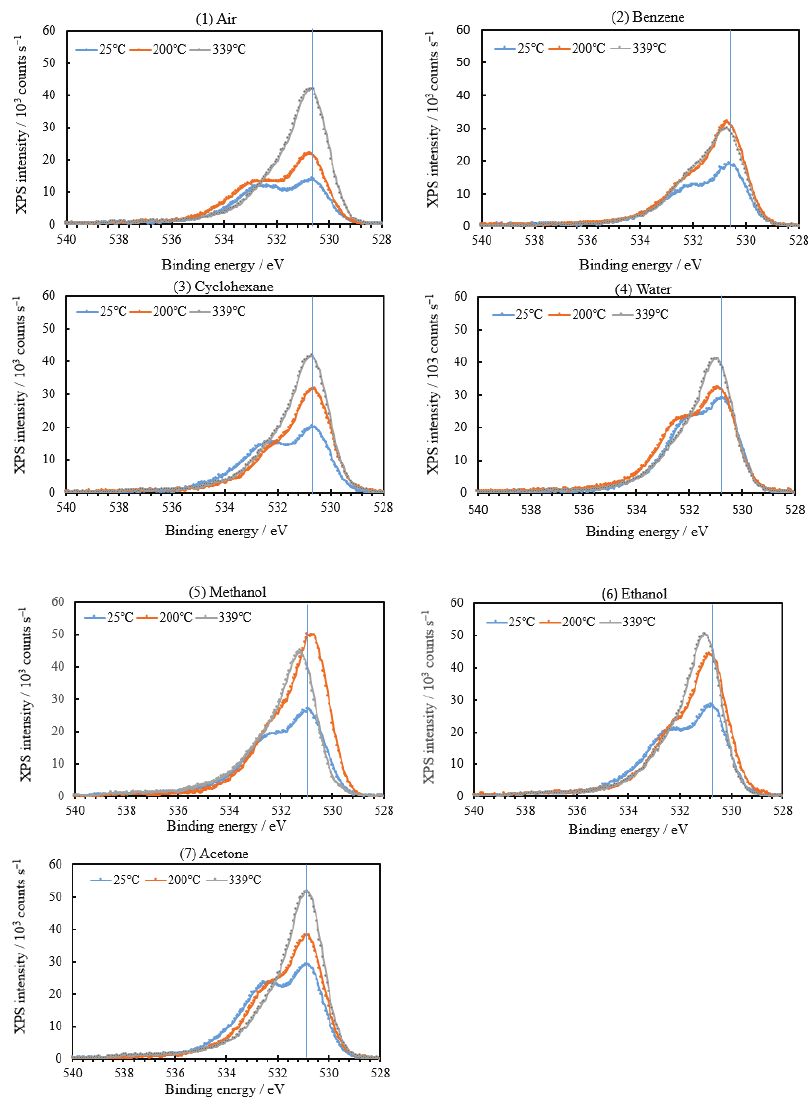
Figure 3. Temperature dependence of O 1 s spectra of real iron surfaces scratched in different environments: (1) air, (2) benzene, (3) cyclohexane, (4) water, (5) methanol, (6) ethanol, and (7)